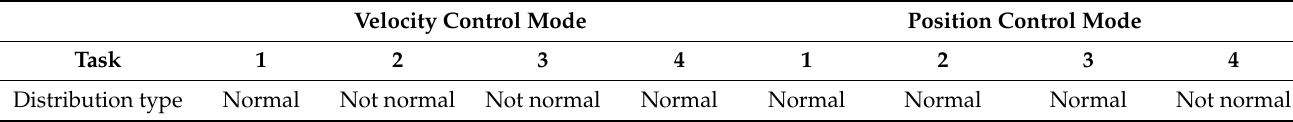
Table A4. Differential gear-based design joint sample distributions.